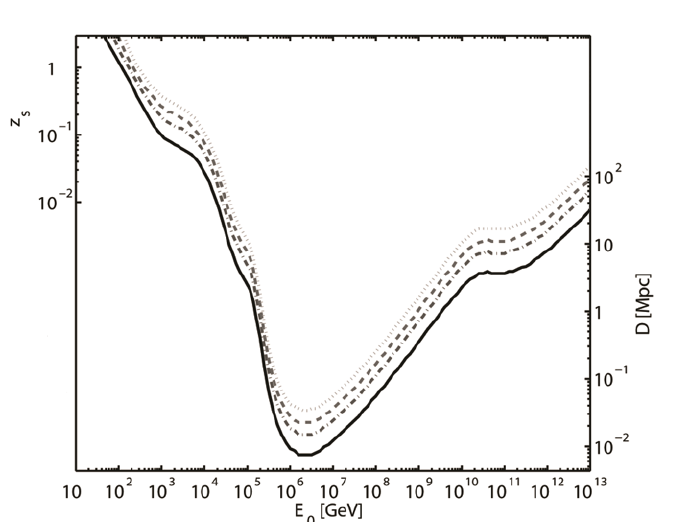
Figure 7. Source redshifts z s at which the optical depth takes fixed values as a function of the observed hard photon energy E 0 ; the y -scale on the right side shows the distance in Mpc for nearby sources. The curves from bottom to top correspond to a photon survival probability of e − 1 (cid:39) 0.37 (the horizon), e − 2 (cid:39) 0.14, e − 3 (cid:39) 0.05 and e − 4.6 (cid:39) 0.01. For D (cid:39) 8 kpc the photon survival probability is larger than 0.37 for any value of E 0 . (Credit